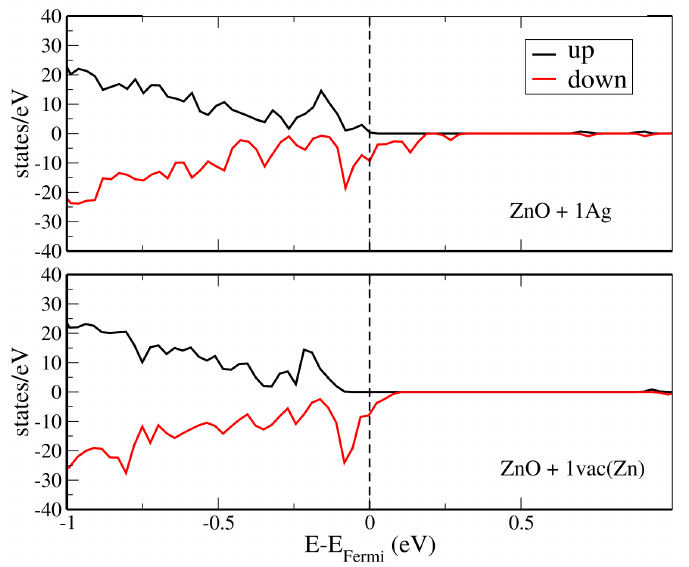
Figure 5. The the spin-polarized density of states for selected ZnO structures. On the top, spin- polarized density observed for a ZnO + 1 Ag system. On the bottom, the similar plot for the ZnO + 1 vac ( Zn ) , i. e., a ZnO system with Zn